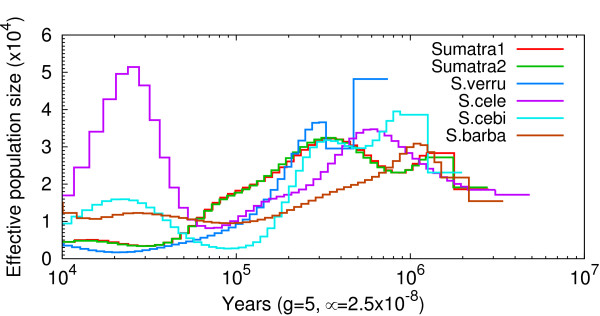
Population sizes of Sus in ISEA inferred from autosomes. Sumatra1/2 = S. scrofa population from Sumatra. S.verru = S. verrucosus; S.cele = S. celebensis; S.cebi = S. cebifrons; S.barba = S. barbatus.